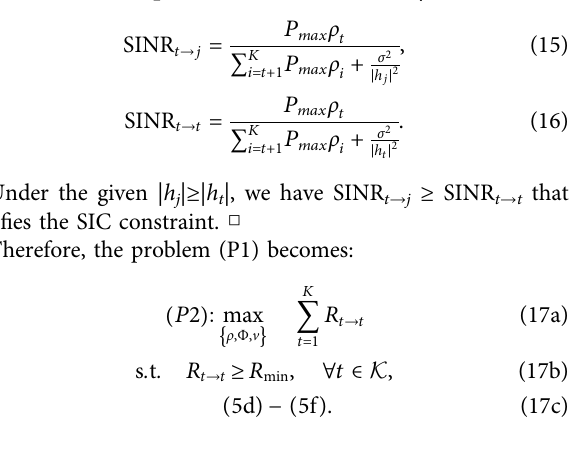
Frontiers in Signal Processing |